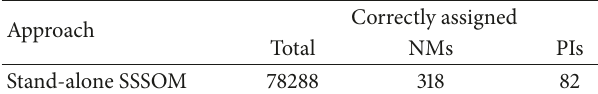
Table 7: Stand-alone SSSOM classification